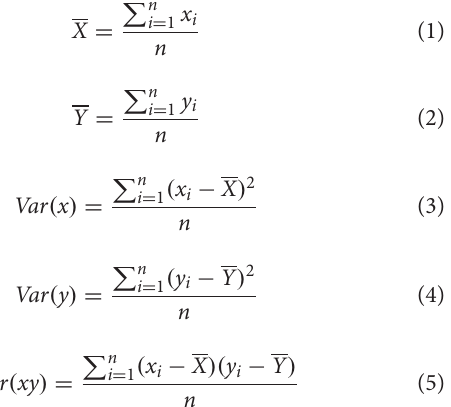
Frontiers in Environmental Science |